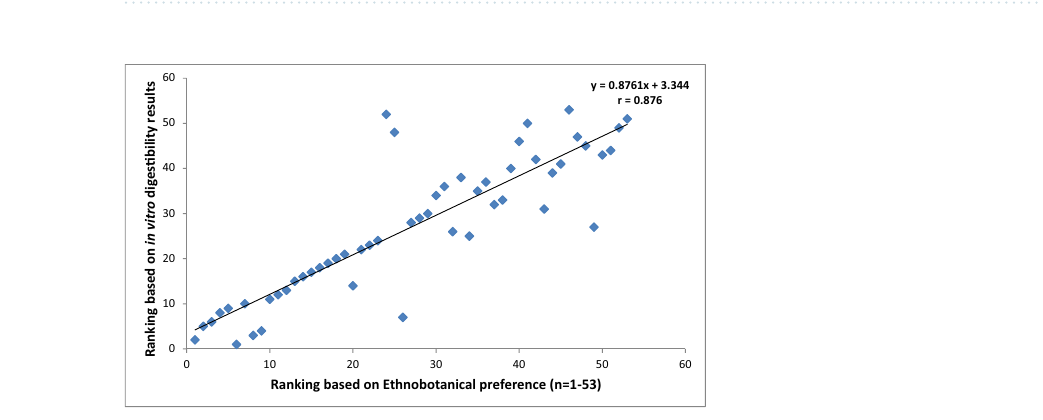
Figure 8. Positive correlation between fodder grass rankings based on ethnobotanical preference versus order of priority based on in vitro digestibility (high to